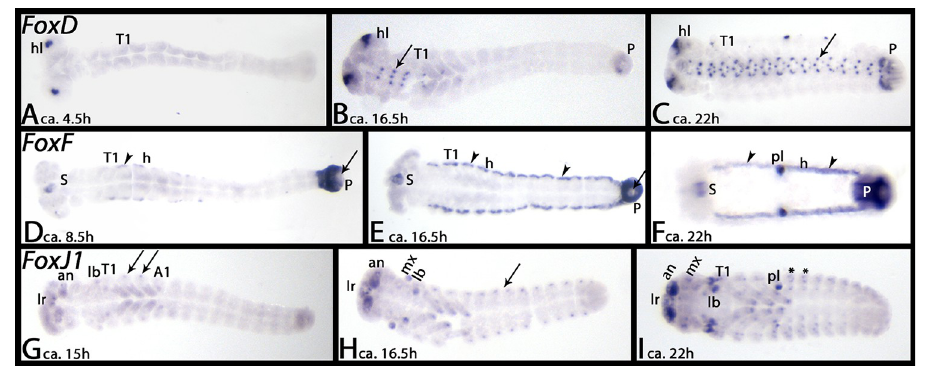
Fig 4. Expression of Tribolium FoxD (A-C), FoxF (D-F) and FoxJ1 (G-I). In all panels, anterior is to the left, ventral view. Embryos are flat-mounted. Arrows in panels B and C mark expression in the VNS. Arrows in panels D and E point to the proctodaeum. Arrows in panels G and H mark dorsal expression. Arrowheads in panels D-F mark expression in the heart (dorsal tube). Asterisks in panel I mark dots of expression in dorsal tissue. Abbreviations in